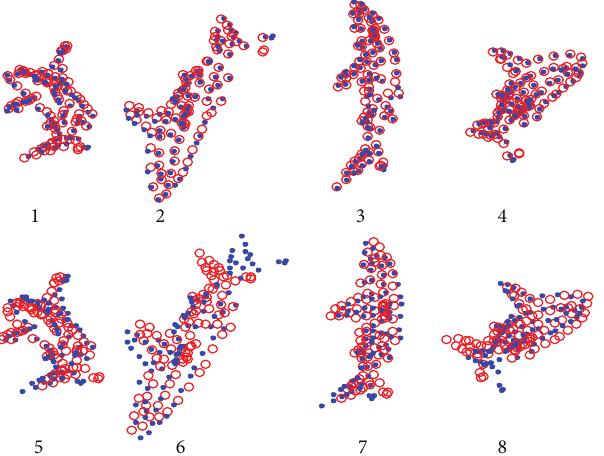
Figure 6: 3D reconstruction results on the “shark” sequence with two methods, respectively. The red dots denote the ground truth coordinates and the blue circles denote the estimation coordinates. The top row is the reconstruction result with sparse approximation and the bottom row is with the DCT trajectory basis method. Both of the results of these two methods are shown with the 1 through different visualizations (better viewed in